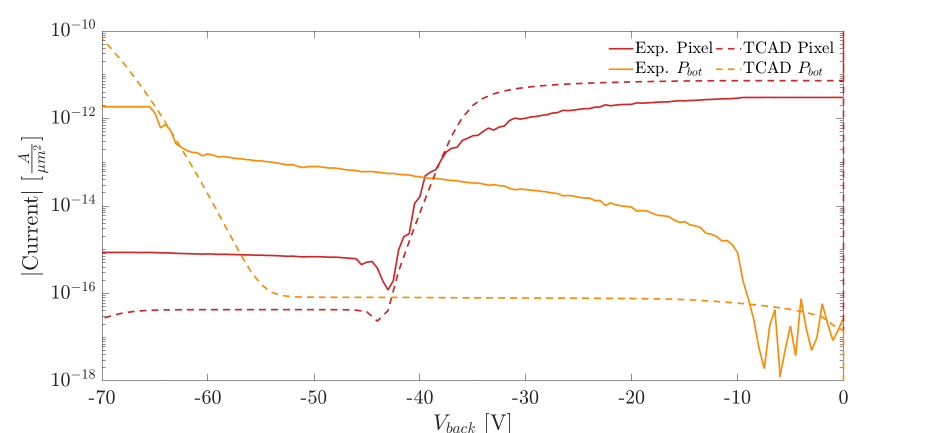
Figure 13. Comparison of the current densities obtained from measurements (Exp.) and simulations (TCAD) for a substrate thickness of 100 µ m.